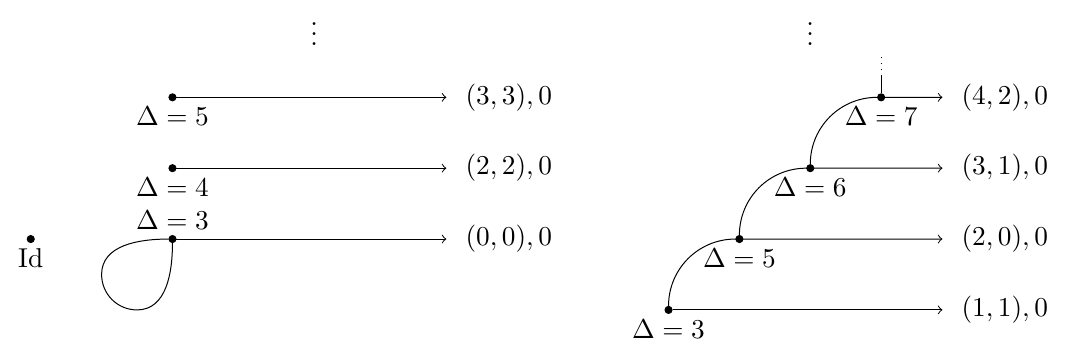
Figure 3 . Topology of (cid:6) in neutral sector after taking into account poles. The dimensions shown near intersections correspond to the block which appears as the residue.